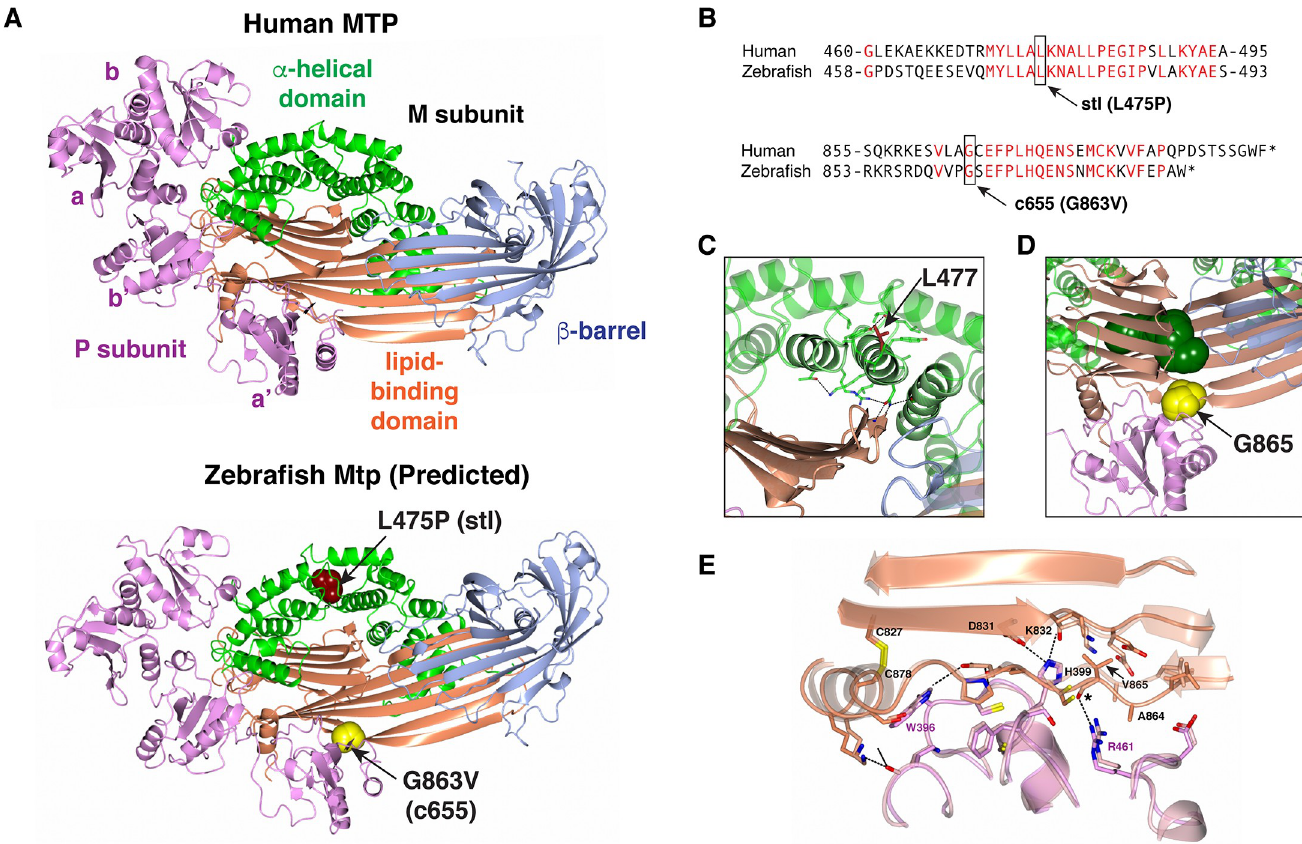
Fig 7. Structural analysis of MTP mutations. (A) Ribbon representation of the human MTP complex (PDB entry 6I7S) and the Zebrafish modeled structure. The positions of L475 and G863 in the Zebrafish structure are shown in space-filling representation. (B) Alignment of human MTP and zebrafish Mtp amino acid sequences surrounding the stl and c655 mutations. (C) Close-up view of the area surrounding L477 in the human MTP complex. The position of L477 (red) is highlighted. The conserved hydrogen bonds linking the helical domain to the tip of the C-sheet of the lipid-binding domain are shown as well as amino acids within 4 Å of L477. (D) Close-up view of the area surrounding G865 in the human MTP complex. The position of G865 (yellow) and the PEG molecule (dark green) which occupies the lipid-binding site in the solved structure are shown in space-filling representation. The a’ domain of PDI (pink) in the complex occludes the lipid entry/ exit site. (E) Close-up view showing the outer strand displacement in sheet A of the lipid-binding domain of the M subunit resulting from the G865V mutation. Asterisk indicates the wild-type backbone carbonyl of G865 hydrogen bonded to R461 of PDI. Panels C–E are colored as in panel A.